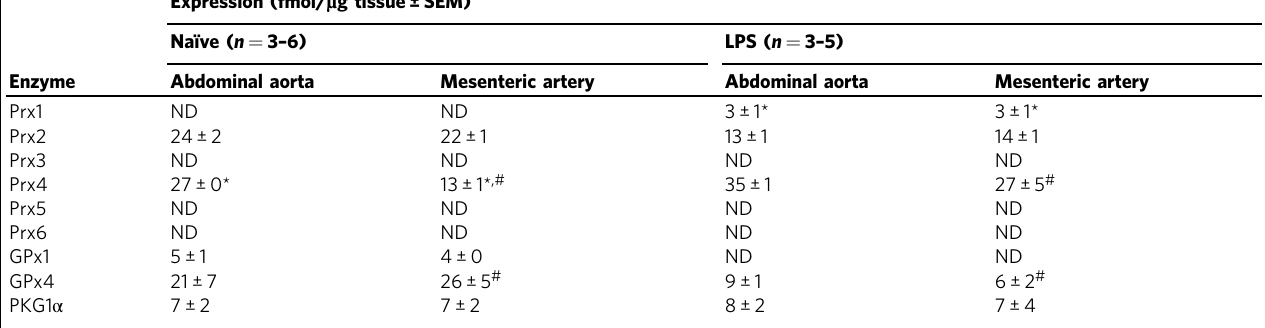
Data are shown as mean±SEM. * p ≤ 0.05 between abdominal aorta and mesenteric artery under same treatment conditions; and # p ≤ 0.05 between abdominal aorta and mesenteric artery under different treatment conditions, as determined by two-way ANOVA with Tukey ’ s post hoc test. ND, not detected or below readily quanti fi able